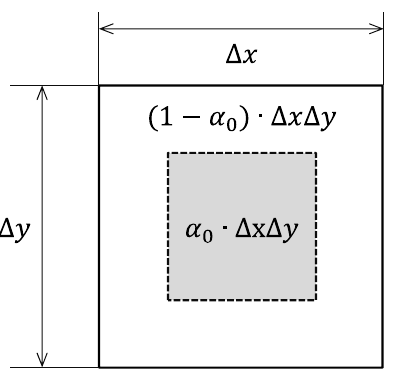
Figure 1. Schematic of simulation grid containing